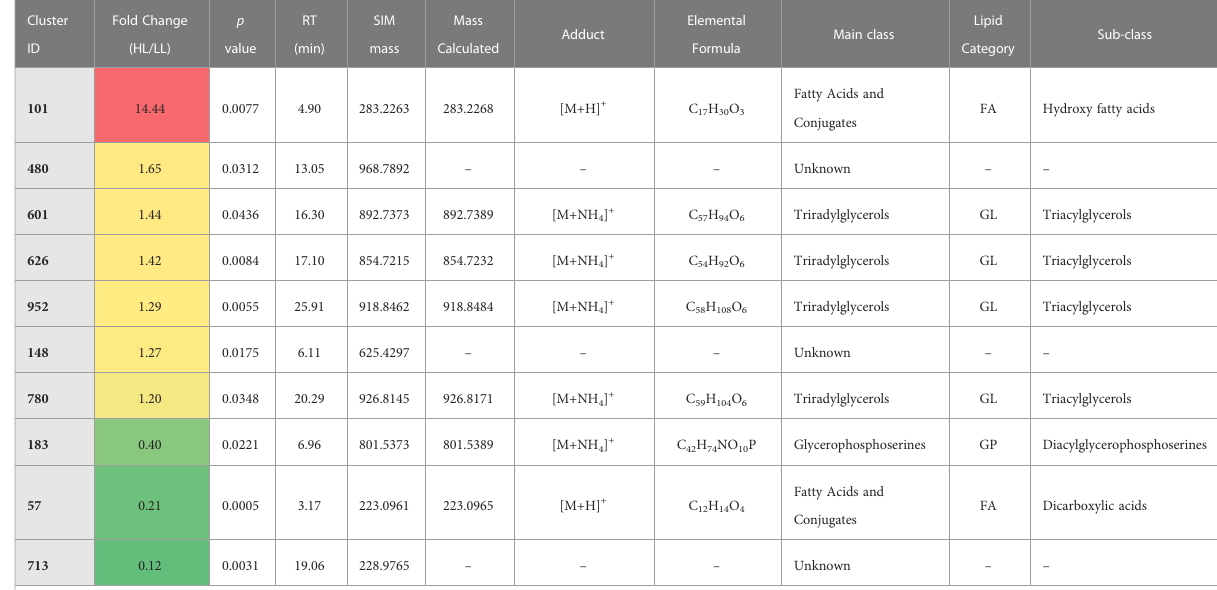
TABLE 2 List of putatively annotated seed lipids with statistical differences between low light (LL) and high light (HL) microclimates at veraison stage of berry development (Student ’ s t-test, p ≤ 0.05). Cluster Fold Change ID (HL/LL) Calculated